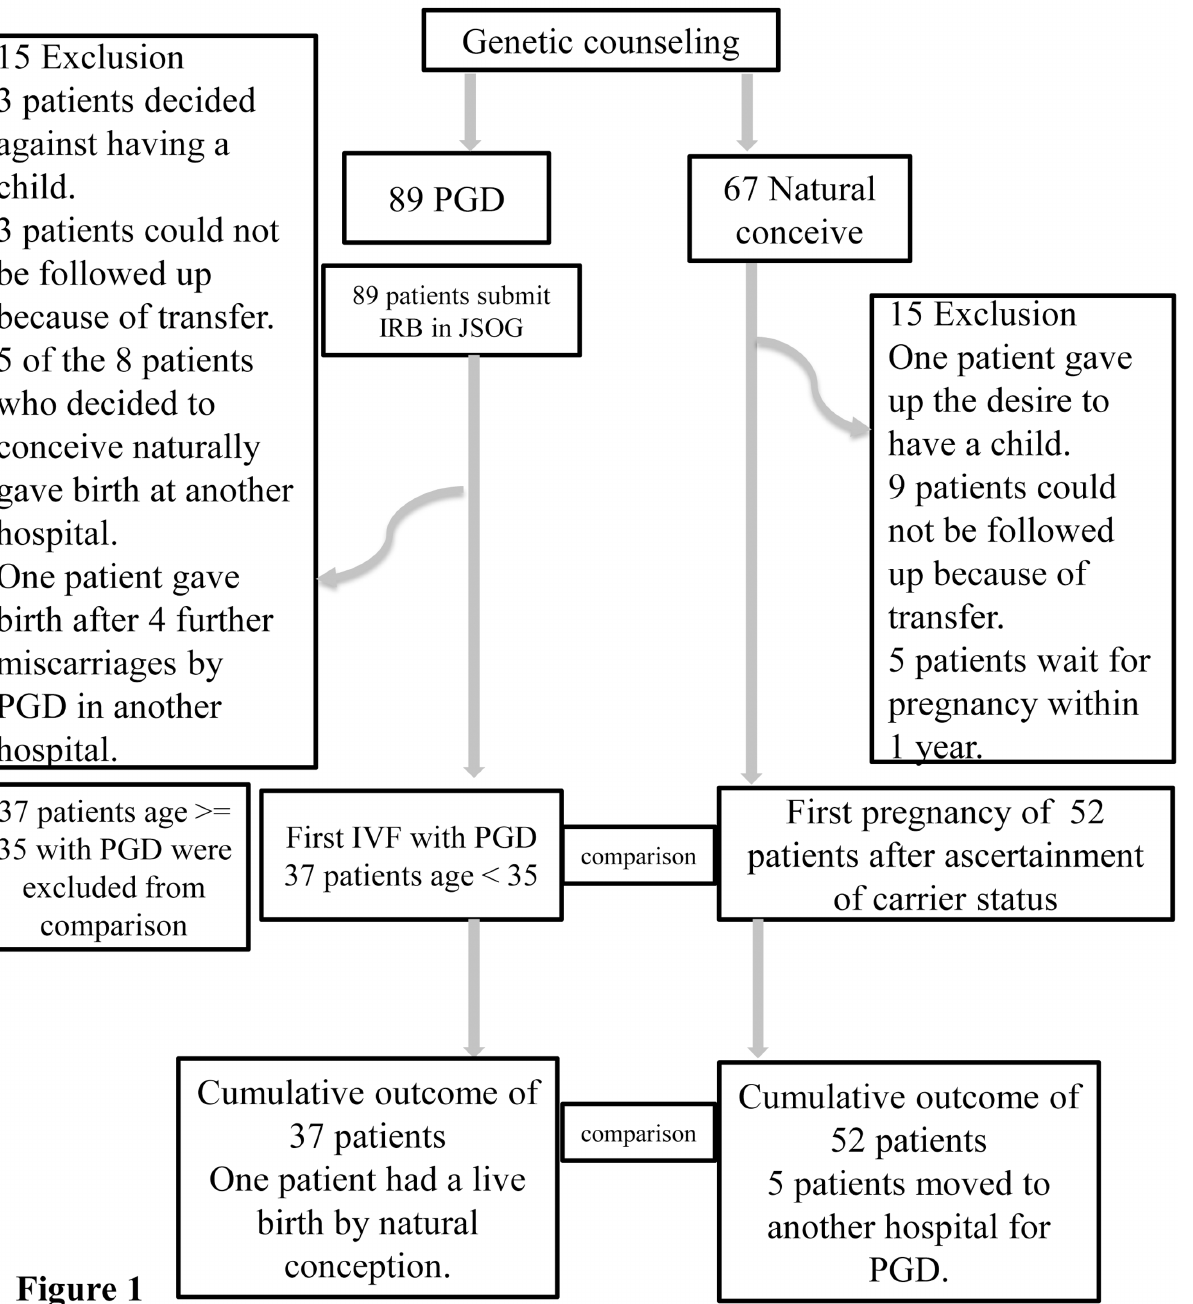
PLOS ONE | DOI:10.1371/journal.pone.0129958 June 17,